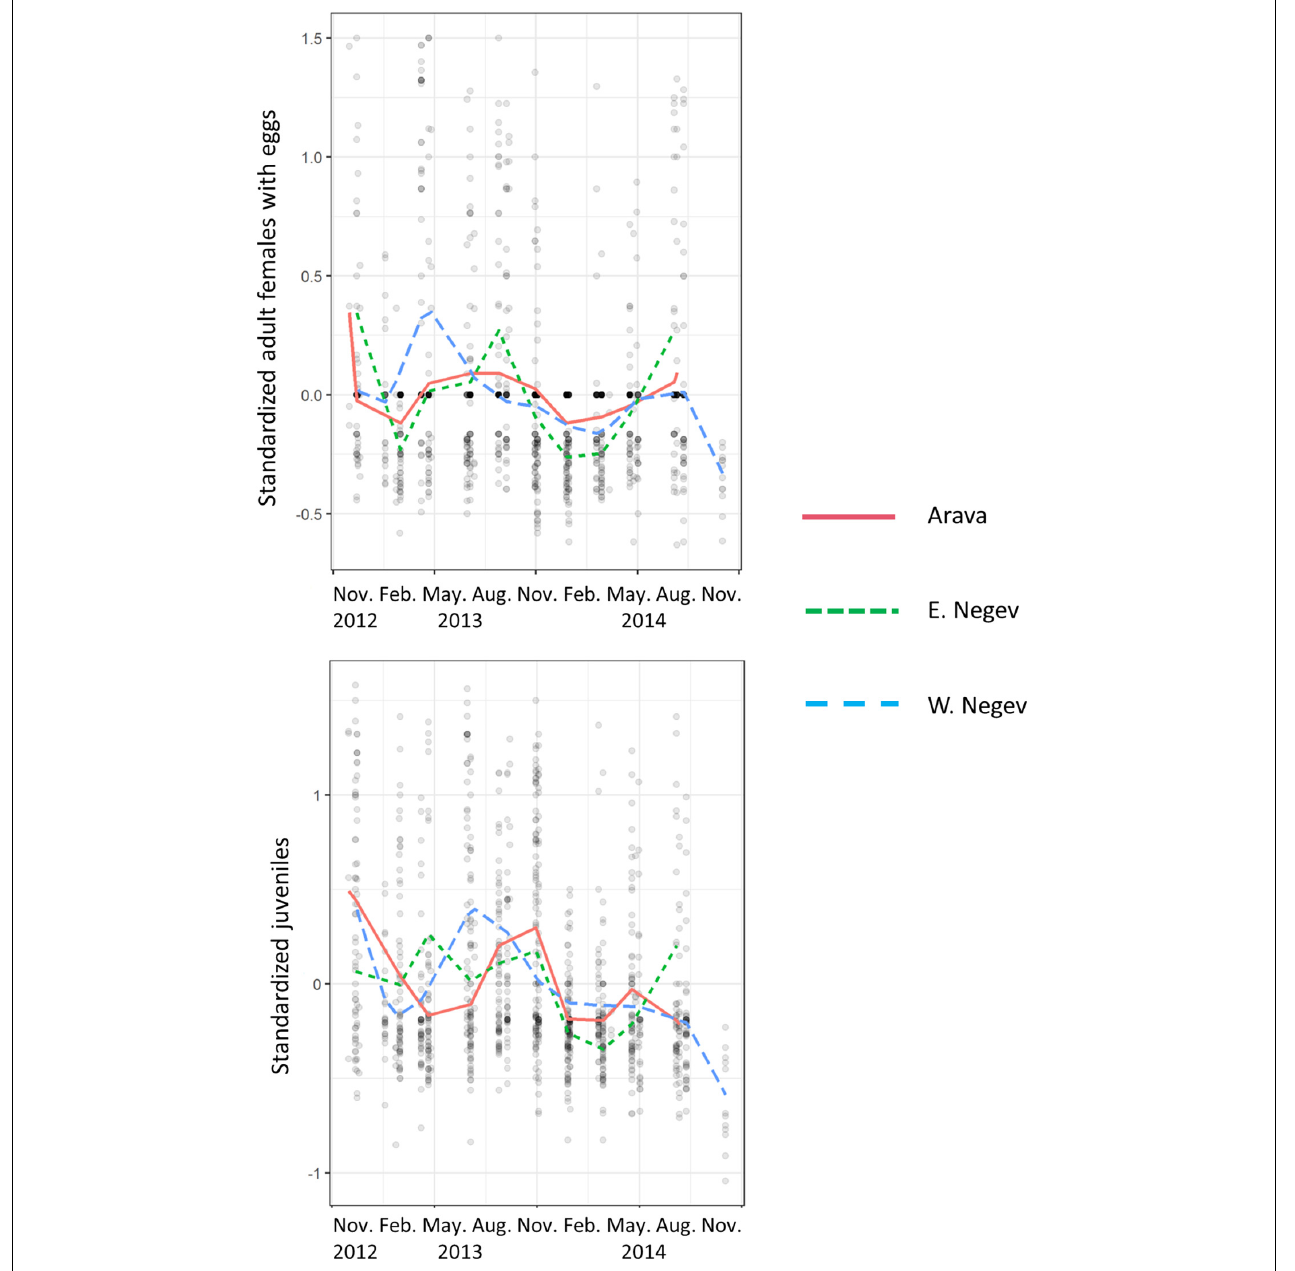
FIGURE 3 | Seasonal fluctuations in standardized colony size, separated by region and spider age class (adult females with eggs and juveniles). Curves are uniform splines of 8